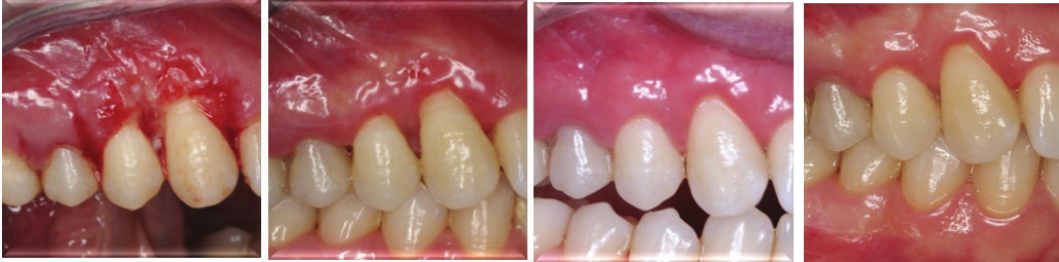
Figure 6: Postoperative 1st week’s and 1st, 6th, and 12th months’ clinical appearance of the surgical site,